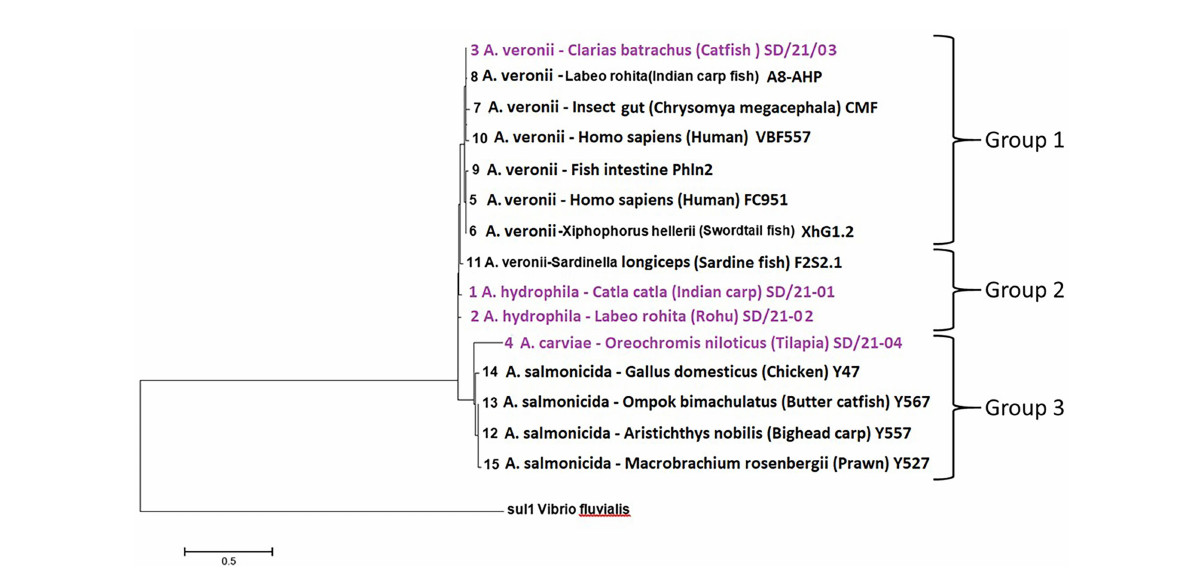
FIGURE 4 Phylogenetic analysis of D class β -lactam resistance genes from 15 Aeromonas spp. from different host species in India. (i) Group 1 consists of the bla OXA-12 gene from A. veronii isolates, (ii) Group 1 had the bla OXA-724 gene from A. veronii , and A . hydrophila isolates while (iii) Group 3 has the bla OXA-427 gene from A. caviae and A. salmonicida